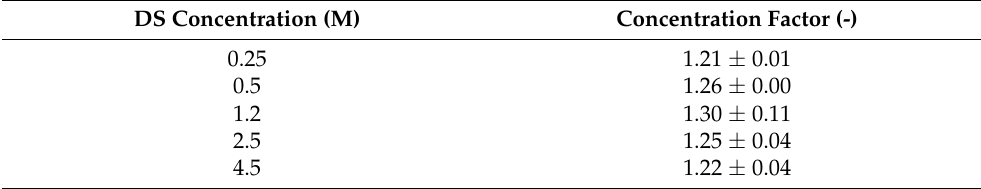
Table 4. Concentration factors at different DS concentrations after 5.5 h of FO